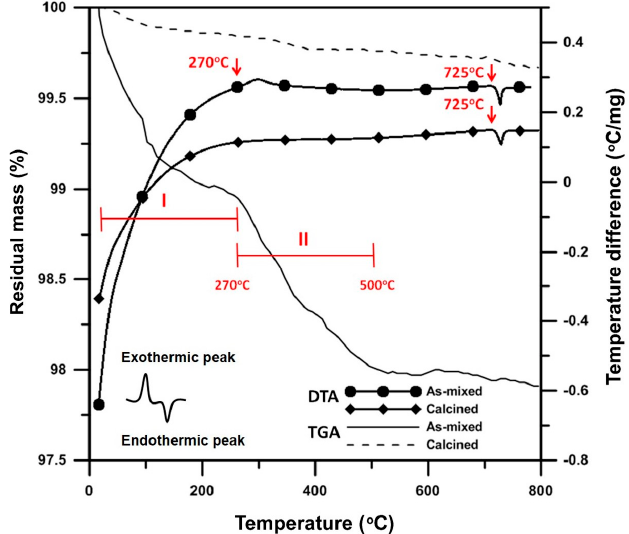
Figure 2. Differential thermal analysis (DTA) and thermogravimetric analysis (TGA) analysis of B1V die-pressed mixture after calcination at 650 °C for 24 h, labeled “Calcined”, or without calcination, labeled “As-mixed”.